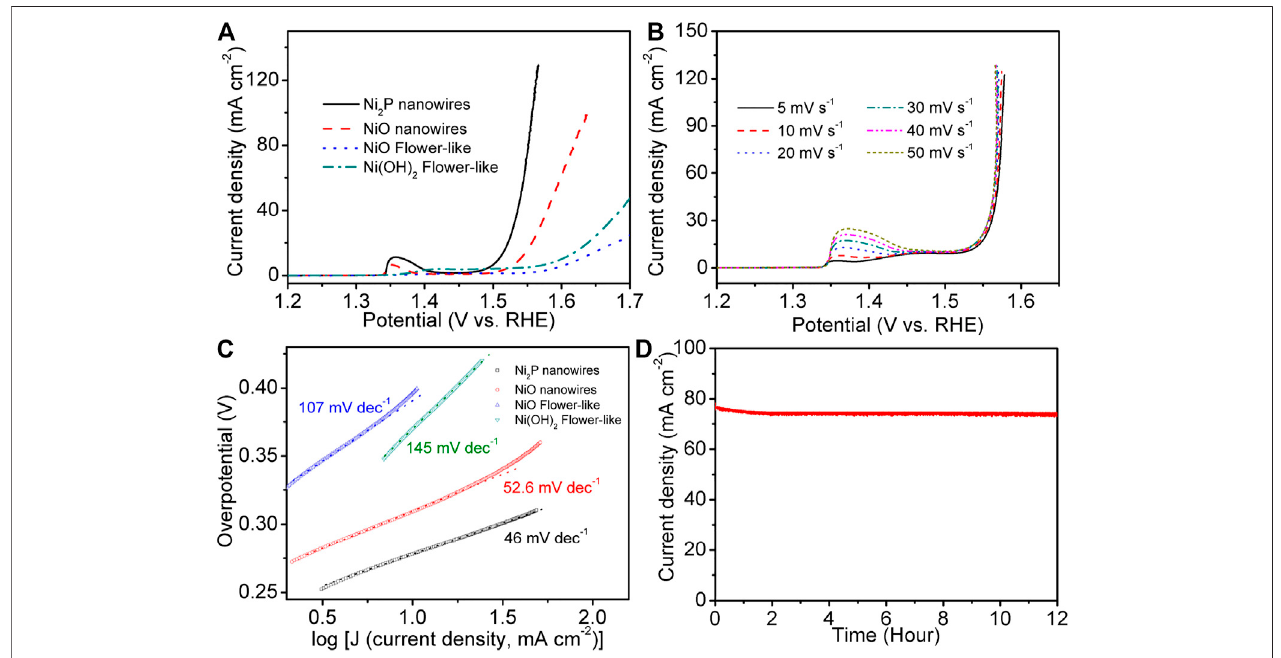
FIGURE7|(A) LSVcurvesofNi 2 Pnanowires,NiOnanowires,Ni(OH) 2 fl ower-likeat5 mV s − 1 in1 MKOH. (B) LSVcurvesofNi 2 Pnanowiresatdifferentscanrates. (C) Tafel plots of the OER activity. (D) The stability of the Ni 2 P nanowires tested in amperometric i-t curve at 1.7 V vs. RHE.